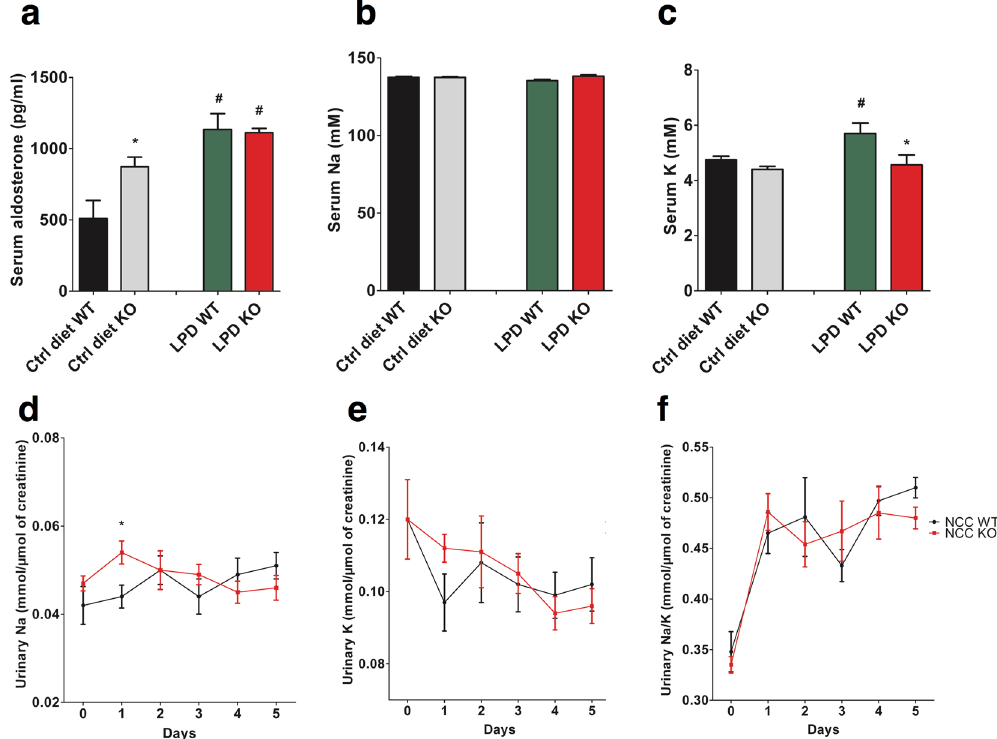
Figure 8. Effect of dietary phosphate depletion on blood and urinary electrolytes and circulating aldosterone levels in WT and NCC KO mice: ( a – c ) Arithmetic means ± SEM (n = 6–7) of serum aldosterone ( a ), Na ( b ) and K ( c ) levels in NCC WT mice (black bars) and NCC KO (grey bars) under normal diet (Ctrl diet, left bars) and following dietary phosphate depletion for 5 days (LPD, right bars). * (p < 0.05) indicates significant difference from NCC WT mice, # (p < 0.05) indicates significant difference from normal diet. ( d – f ) Arithmetic means ± SEM (n = 6–7) of urinary Na excretion ( d ) urinary K excretion ( e ) and the ratio of urinary Na to K excretion ( f ) in NCC KO and WT mice under normal diet (Day 0) and following dietary phosphate depletion (Day 1–5). * (p < 0.05) indicate significant difference from NCC WT